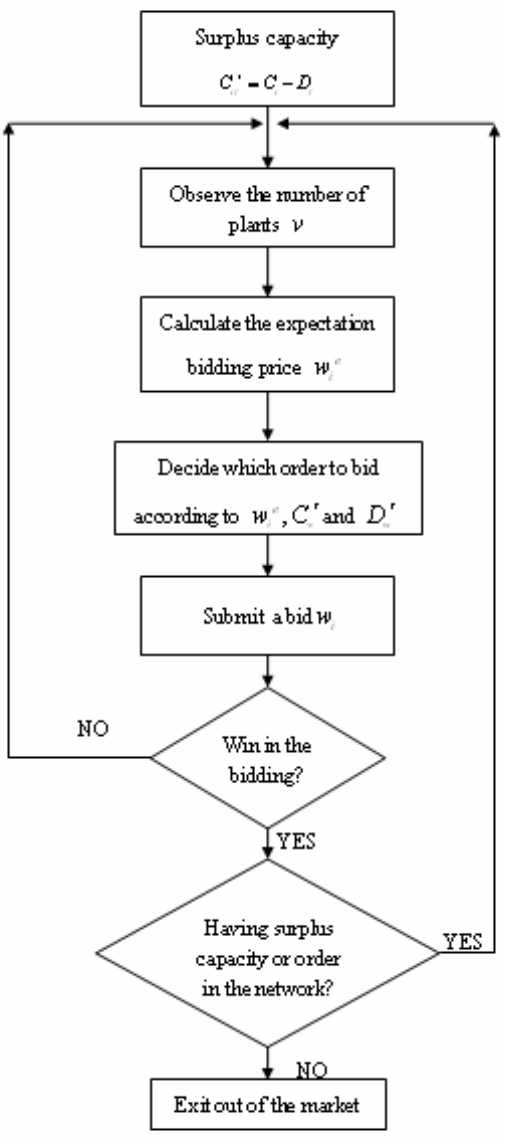
Fig. 1.3. Decision making process of a plant whose capacity is surplus